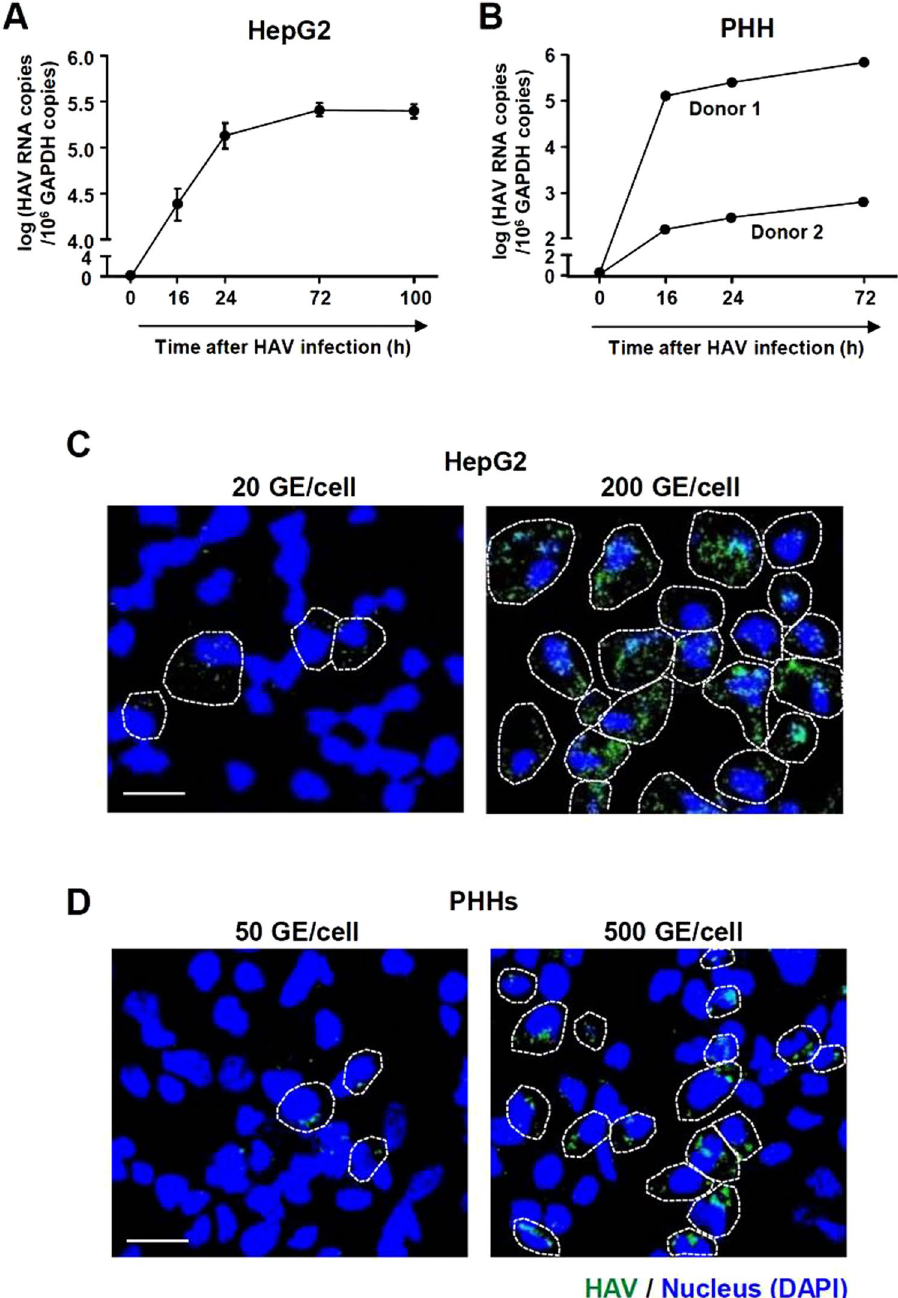
Figure 1. Infection of HM-175/18 f HAV in HepG2 cells and PHHs. ( A , B ) HepG2 cells were infected with HM-175/18 f HAV at 200 GE/cell ( A ), and PHHs from two different donors were infected at 500 GE/cell ( B ). Cell pellets were harvested and real-time qPCR was performed to examine intracellular HAV RNA copies. Bar graphs represent the means ± s.e.m. Each experiment was performed in triplicates. ( C , D ) HepG2 cells were infected with HM-175/18f HAV at 20 GE/cell or 200 GE/cell ( C ), and PHHs were infected at 50 GE/cell or 500 GE/cell ( D ). After 48 hours, immunofluorescence staining was performed to identify HAV-infected cells. Nucleus was stained with DAPI. Scale bar represents 20 μ m. HAV antigen-positive cells are demarcated by dashed